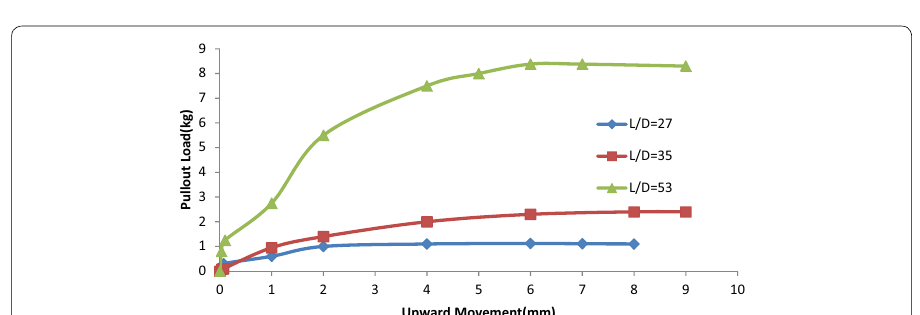
Fig. 15 Pullout load-upward movement curves for helical pile with single helix (dh